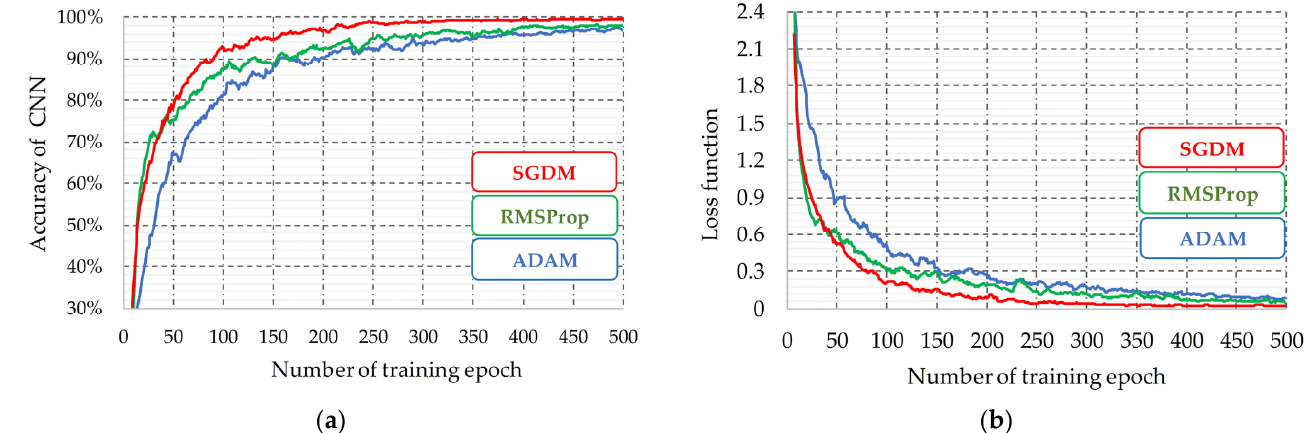
Figure 2. Analysis of the CNN training algorithm—learning curves: ( a ) accuracy of the CNNs for testing data; ( b ) loss function.